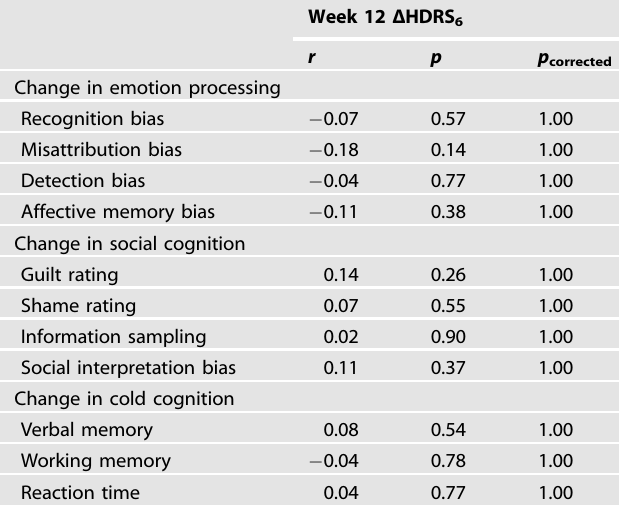
Table 2. Correlation between change in cognitive score and week 12 Δ HDRS 6 .